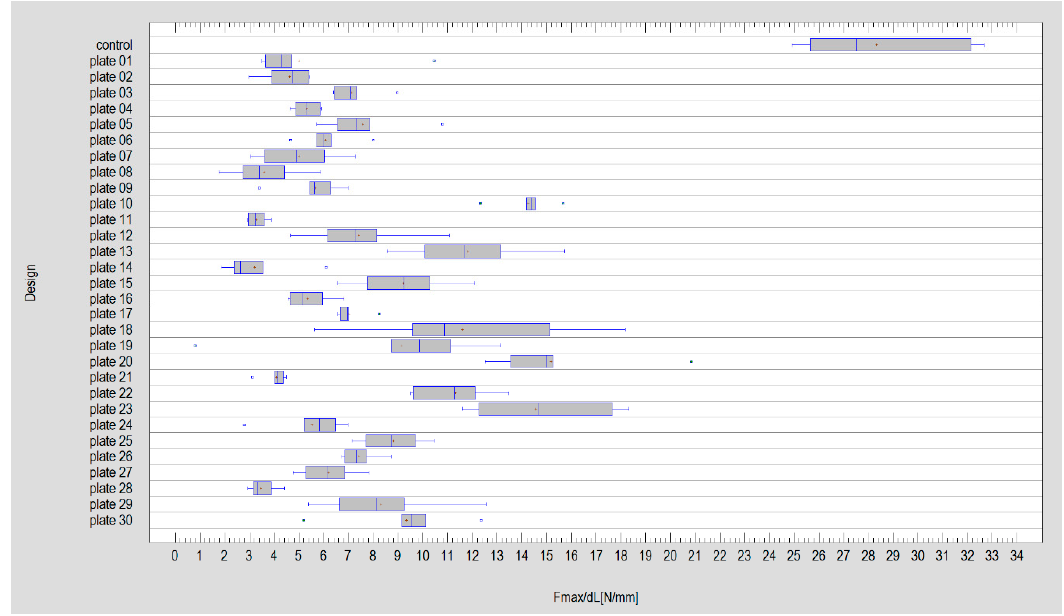
Figure 3. General comparison of the amount of required force for one-millimeter displacement in fracture line after plate fixation. Data in Newtons.